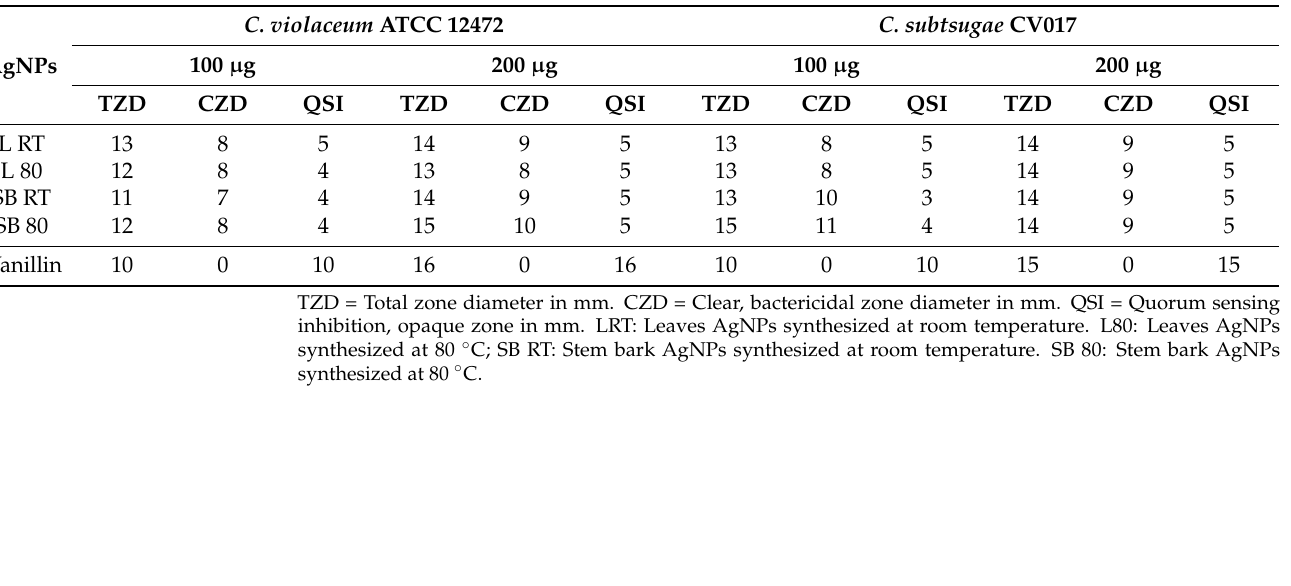
Figure 10. Qualitative agar overlay bioassay of D. villosa stem bark AgNPs synthesized at room temperature (RT) and at 80 ◦ C using Chromobacterium subtsugae CV017 ( a ) and Chromobacterium violaceum ATCC 12472 ( b ), as well as D. villosa leaves AgNPs at RT and at 80 ◦ C using C. subtsugae CV017 ( c ) and C. violaceum ATCC 12472 ( d ), displaying quorum sensing inhibition (non-pigmented zones) and antimicrobial (translucent zones) activities. Table 4. Zone of inhibition (mm) of D. villosa leaves and stem bark AgNPs against C. subtsugae and C. violaceum biosensors.